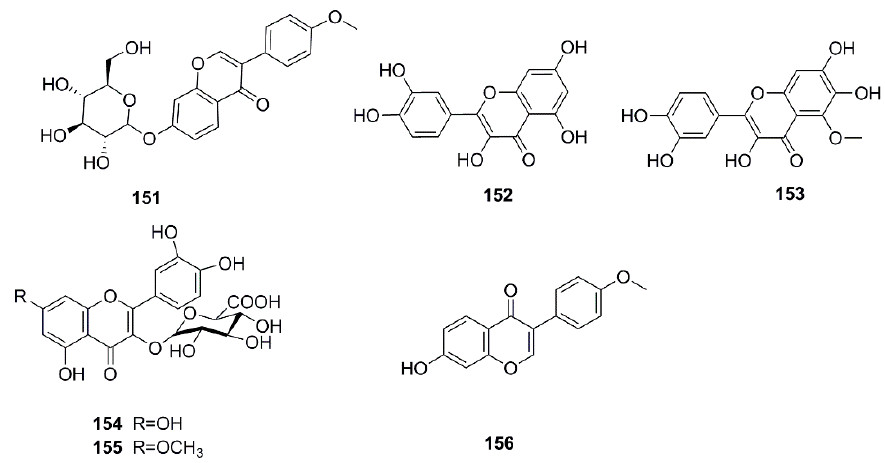
Figure 9. Chemical structures of the flavonoids in X. strumarium.